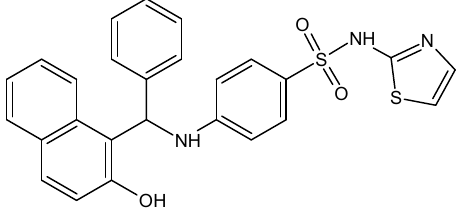
Fig. 1. The chemical structure of